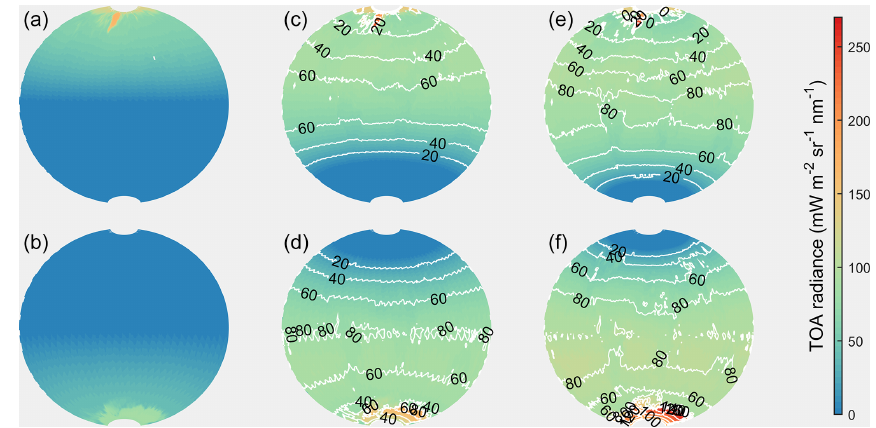
Figure 3. The global distributions of the maximum SBR received by spaceborne DWLs operating on the three orbits. Panels (a, b) , (c, d) , and (e, f) present the sun-synchronous orbits with LTANs of 18:00, 15:00, and 12:00LT, respectively, and the upper panels denote the SBR in summer, and the lower panels denote the SBR in winter. The contours in (c, e) denote the values of SBR in (c, e) minus the value in (a) , and the contours in (d, f) denote the values of SBR in (d, f) minus the value in (b)